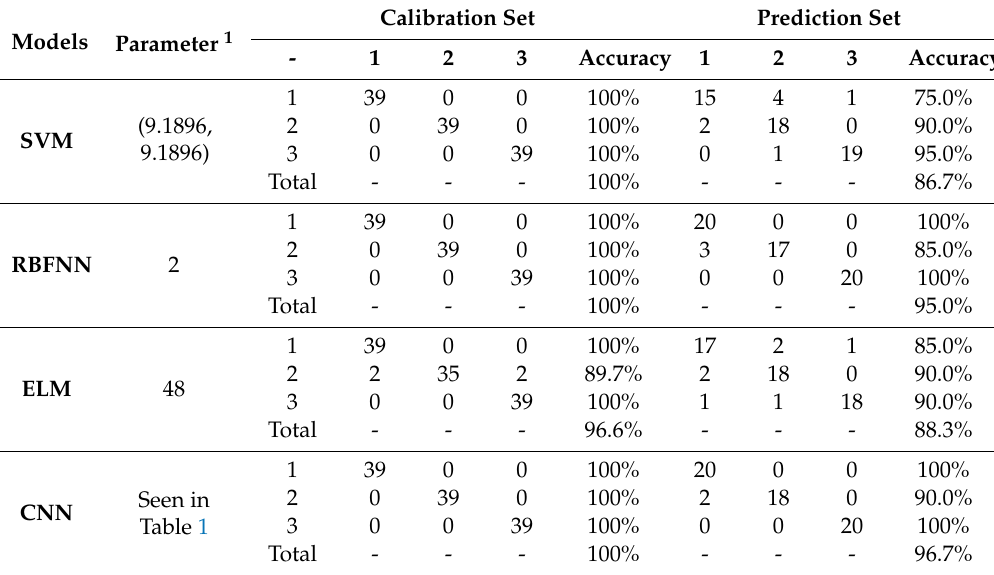
Table 2. The discriminant results of support vector machine (SVM), radial basis function neural network (RBFNN), extreme learning machine (ELM), and convolutional neural network (CNN) models on the full spectra.